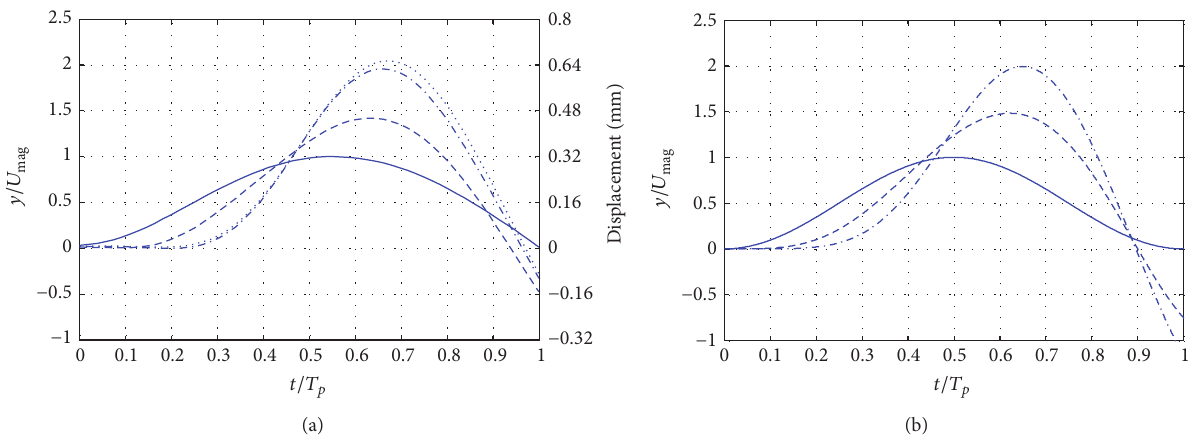
Figure 19: Measured displacement response of the thin secondary beam system with no friction and its comparison with simulation. (a) Measured. Solid line: base input. Dashed line: response at the end of the primary beam (sensor 2). Dash-dotted line: response at the end of the secondary beam (sensor 3). Dotted line: response at the end of the secondary beam (sensor 4). (b) ODE simulation. Solid line: base input. Dashed line: response of the primary mass. Dash-dotted line: response at the secondary mass.